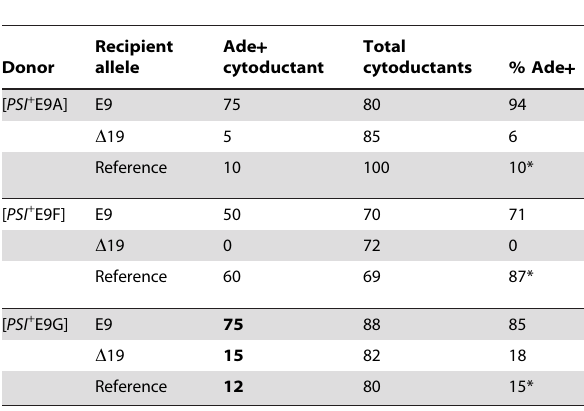
Table 1. Variable transmission of [ PSI + E9]E9 isolates A, F, and that they are distinct prion